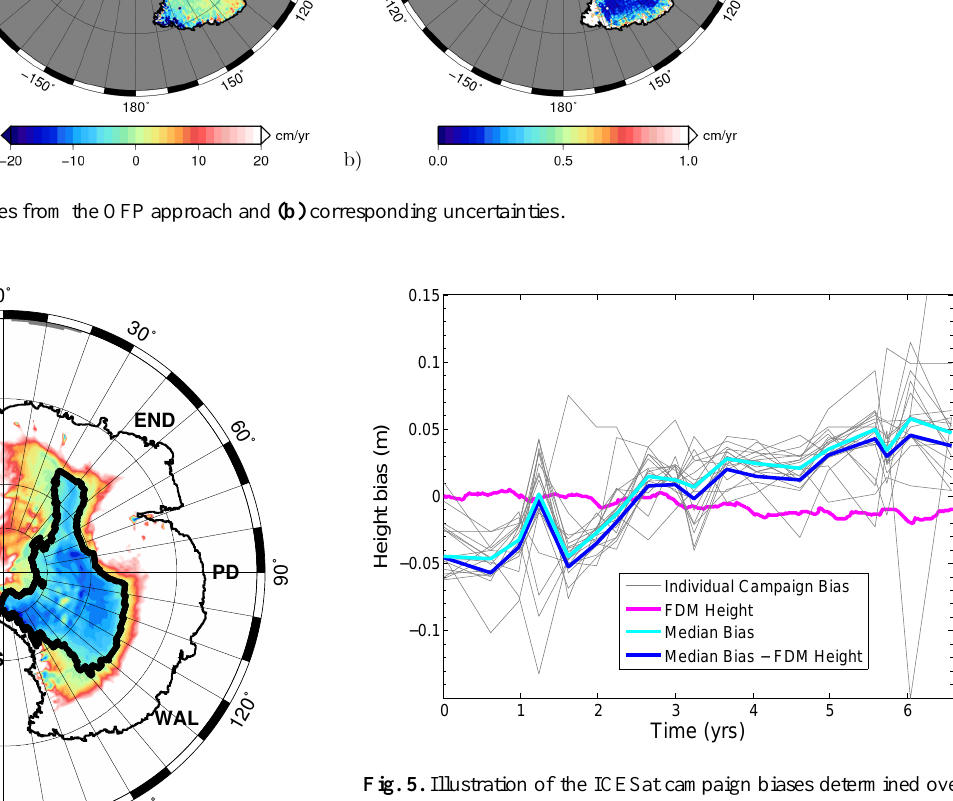
Fig. 5. Illustration of the ICESat campaign biases determined over the LPZ for each individual campaign (grey), the median value (cyan), and the median minus the surface deformation (blue) pre- dicted from the firn densification model (FDM;